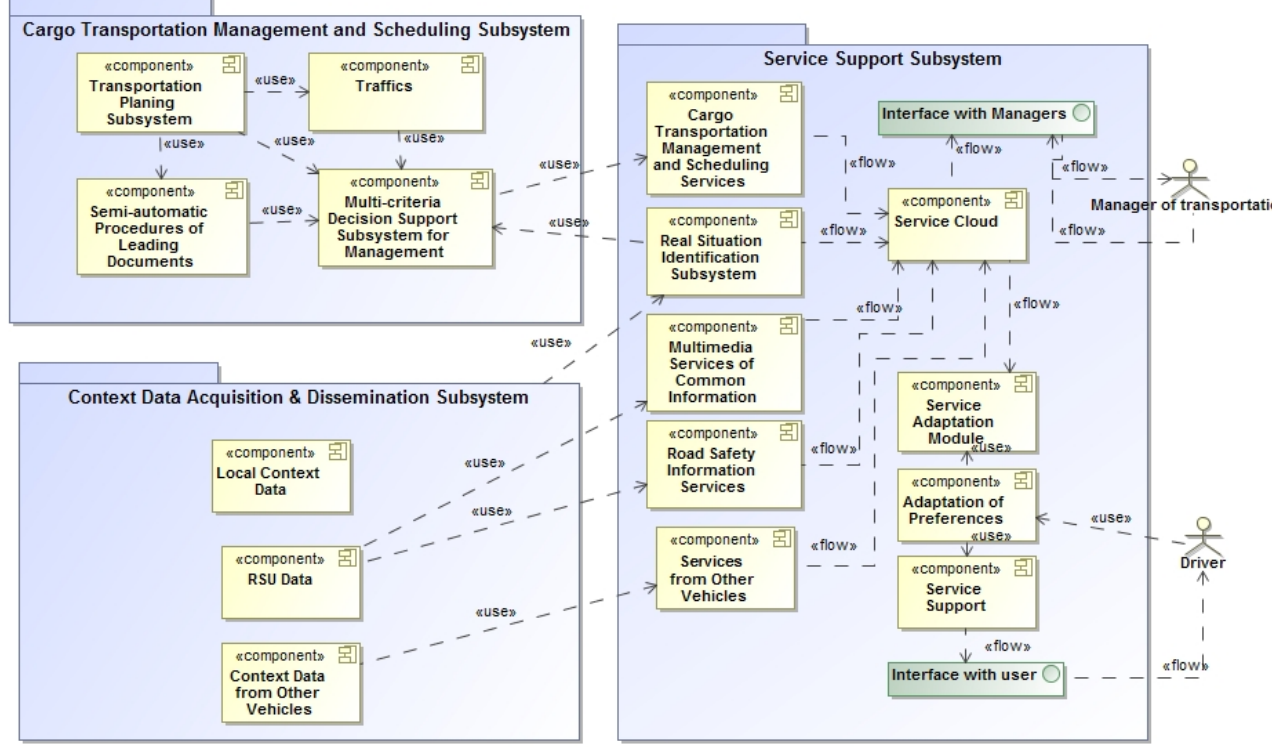
Figure 2. The componential view of e-STMS architecture for service provision to drivers and managers who are participating in intermodal transportation.